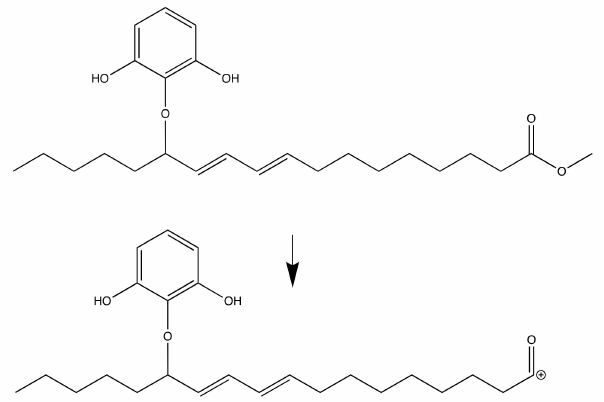
Figure 6. Fragmentation for methyl (9 E ,11 E )-13-(2,6-dihydroxyphenoxy)octadeca-9,11-dienoate.